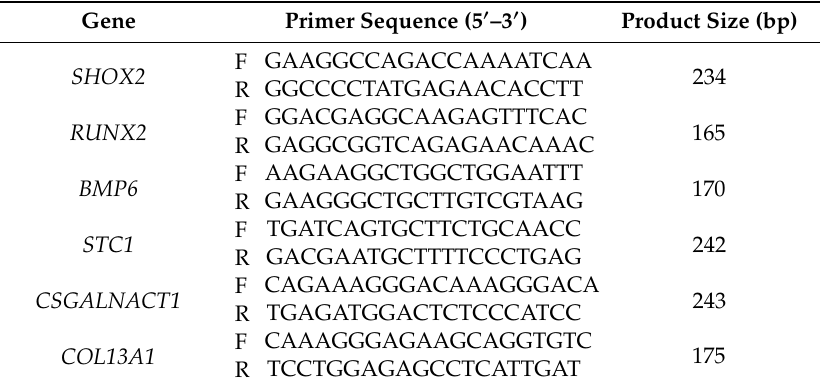
Table 2. Oligonucleotide sequences of primers used for RT-qPCR